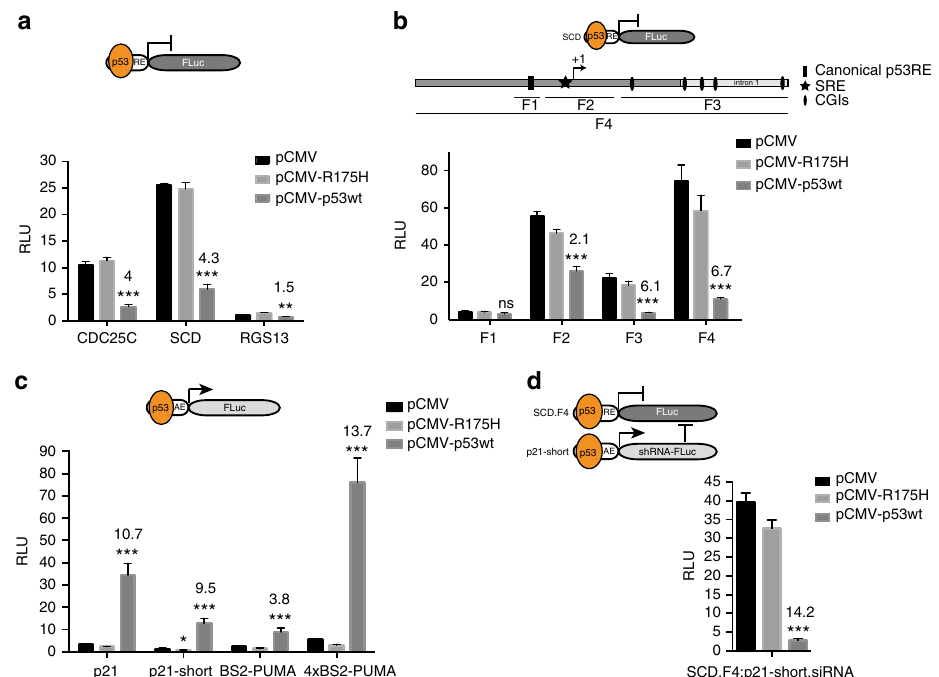
Fig. 1 Development of a genetic p53 sensor. a Relative luciferase expression is shown for three p53-repressed elements (RE) derived from CDC25C , SCD , and RGS13 promoters. b Relative luciferase expression is shown for four different fragments (F) derived from SCD promoter and/or 5 ′ UTR/intron1. c Relative luciferase expression is shown for four p53-activated elements (AE) derived from p21 and PUMA promoters. d Combination of repressed and activated elements. Relative luciferase expression is given for cotransfection of indicated constructs. a , b , c , d The activation/repression folds were calculated between pCMV and pCMV-p53wt cotransfections and are given as numbers above the bars. All error bars represent the standard deviation (SD) of three independent experiments and Student ’ s two-tailed t -test values are represented comparing expression between pCMV and pCMV-p53wt cotransfections (*** P < 0.001, ** P < 0.01, * P < 0.05; ns, not signi fi cant; SRE, sterol regulatory element; CGIs, CpG